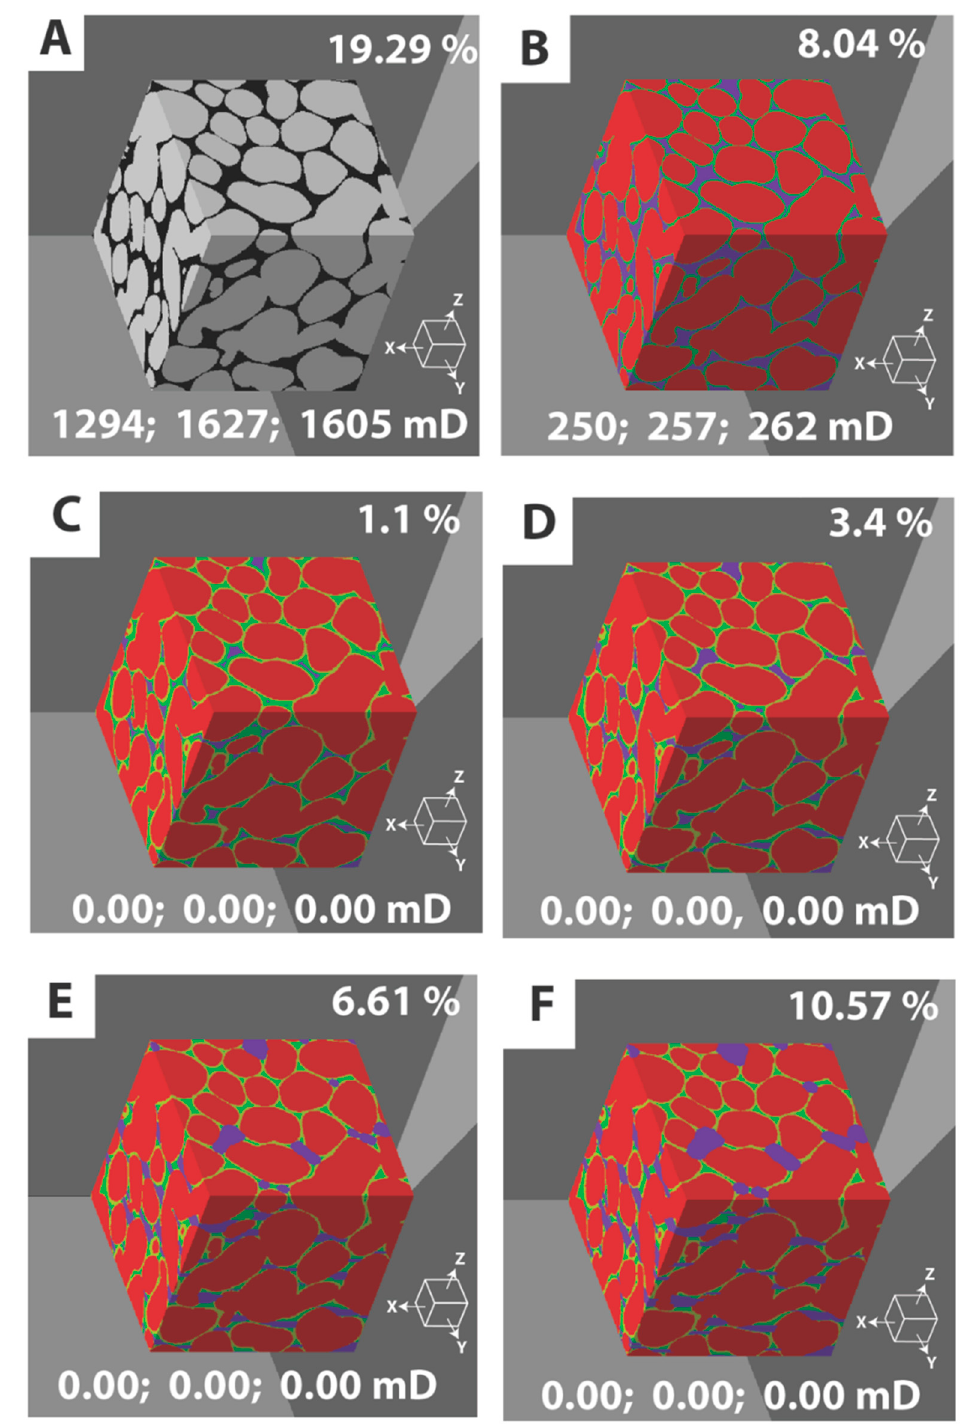
Figure 4. Three-dimensional models of oolitic limestone, developed from a cartoon based 2D image. ( A ) Base binary model of carbonate grains (ooids) and interparticle pores; ( B ) and ( C ) colourised grayscale 3D images representing phase 1 (riming) and phase 2 (pore blocking) cements; ( D )–( F ) as in (B), (C), but illustrating progressive pore dissolution. All images also show recorded porosity (top right), and permeability in the X, Y and Z directions (bottom); with results obtained through the use of the PAT software.